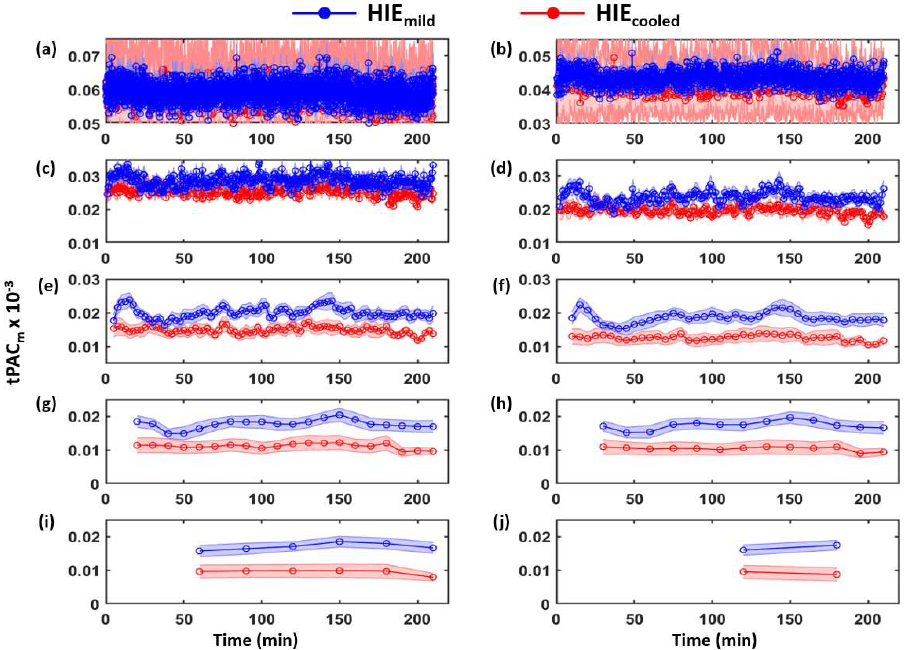
Figure A7. tPAC m indexes at O2 from HIE mild (blue) and HIE cooled (red) under ( a ) 10 s; ( b ) 20 s; ( c ) 1 min; ( d ) 2 min; ( e ) 5 min; ( f ) 10 min; ( g ) 20 min; ( h ) 30 min; ( i ) 60 min; ( j ) 120 min window sizes. Each point denotes the cross-neonate average of tPAC m for the group at different time in the 6 HOL. The shaded error bar indicates the standard error of the mean. t = 0 indicates the start of EEG re- cording.